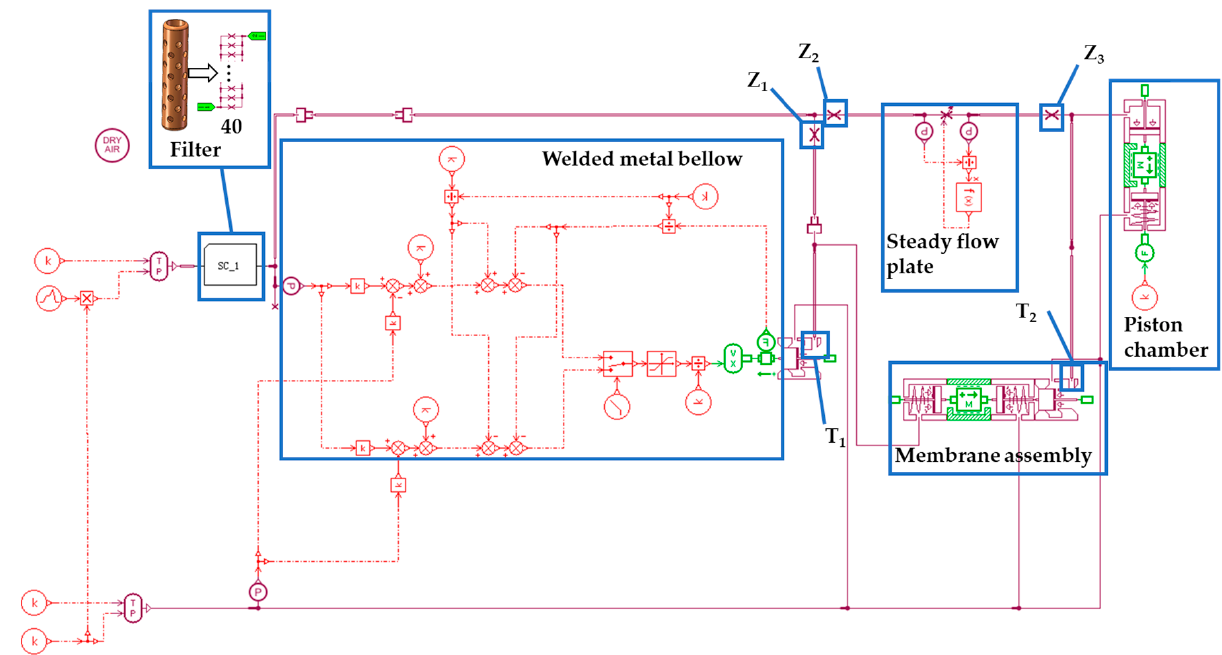
Figure 8. Integral model of two-stage differential pressure control vent valve.